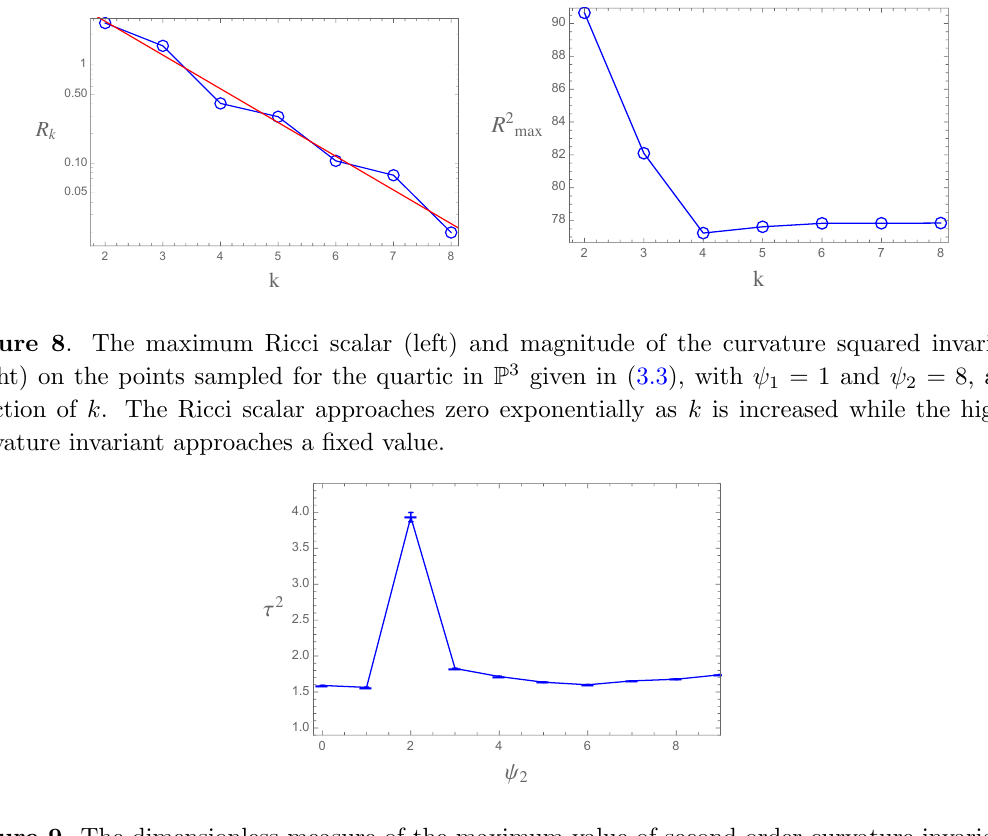
Figure 9 . The dimensionless measure of the maximum value of second order curvature invariants on the sampled points, (cid:28) 2 from (3.1), as a function of 2 with 1 = 1 for the two parameter family of quartics in P 3 (3.2). The expected features in this plot, given the known location in moduli space of curvature singularities, are correctly